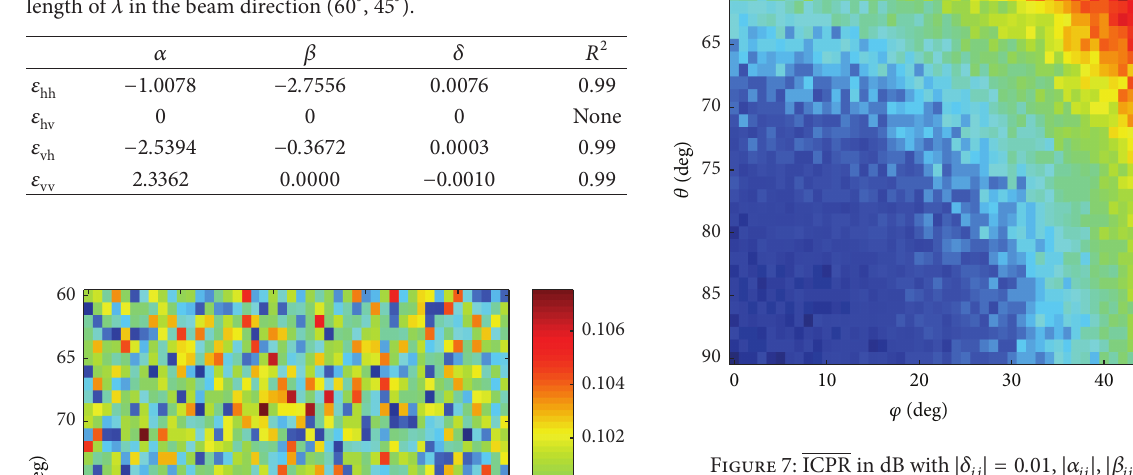
Figure 7: ICPR in dB with |𝛿 𝑖𝑗 | = 0 . 01, |𝛼 𝑖𝑗 |,|𝛽 𝑖𝑗 | ∼ 𝑈( 0 , 2 ) .